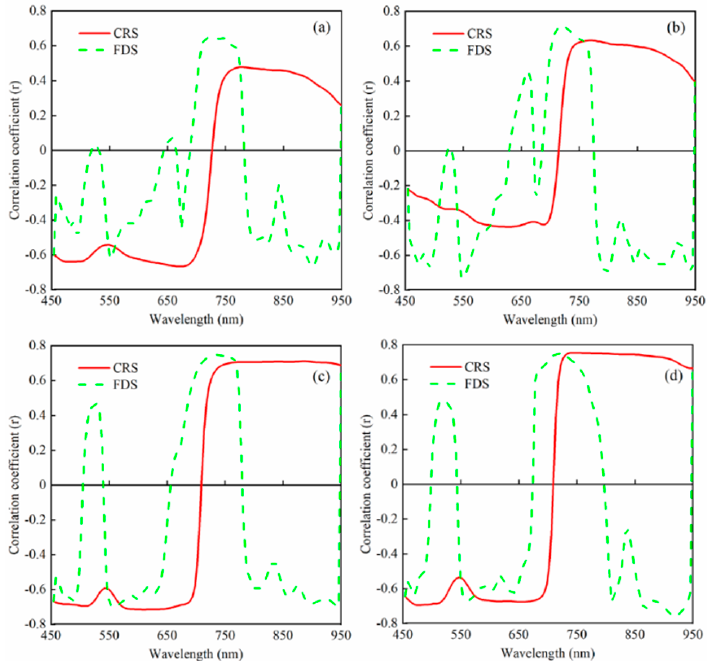
Figure 4. Correlation coefficients between CRS, FDS and AGB at various potato-growth periods: ( a ) bud period, ( b ) tuber-formation period, ( c ) tuber-growth period, ( d ) starch-storage period. According to the threshold results set in Figure 4, the characteristic wavelengths extracted by MWPLS, MC-UVE, and RF methods based on CRS and FDS at each potato- growth period are shown in Figure 6. From the results of the distribution map, the specific number of characteristic wavelengths obtained by different methods based on the two spectral variables in each growth period is different, but the overall position is roughly the same, mainly located in “four sides, one valley and one peak”, which confirms